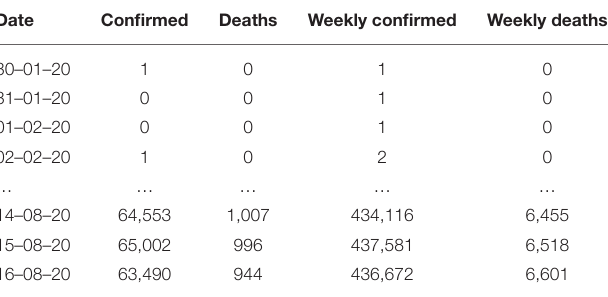
TABLE 3 | Daily and weekly sample data for COVID-19.